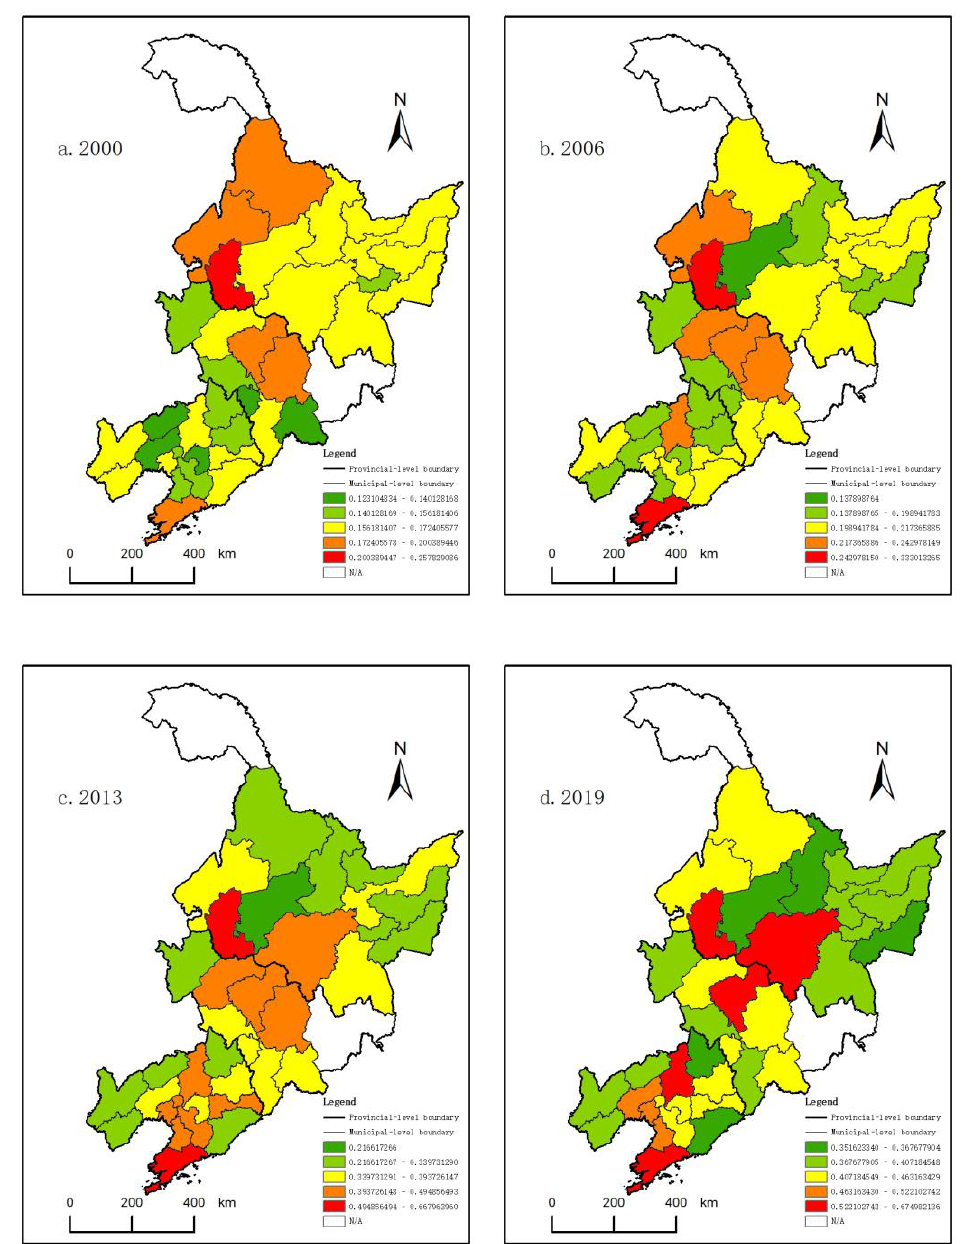
Figure 5. Spatial Distribution of Urban Development Levels in Northeast China. ( a ) 2000; ( b ) 2006; ( c ) 2013; ( d ) 2019.